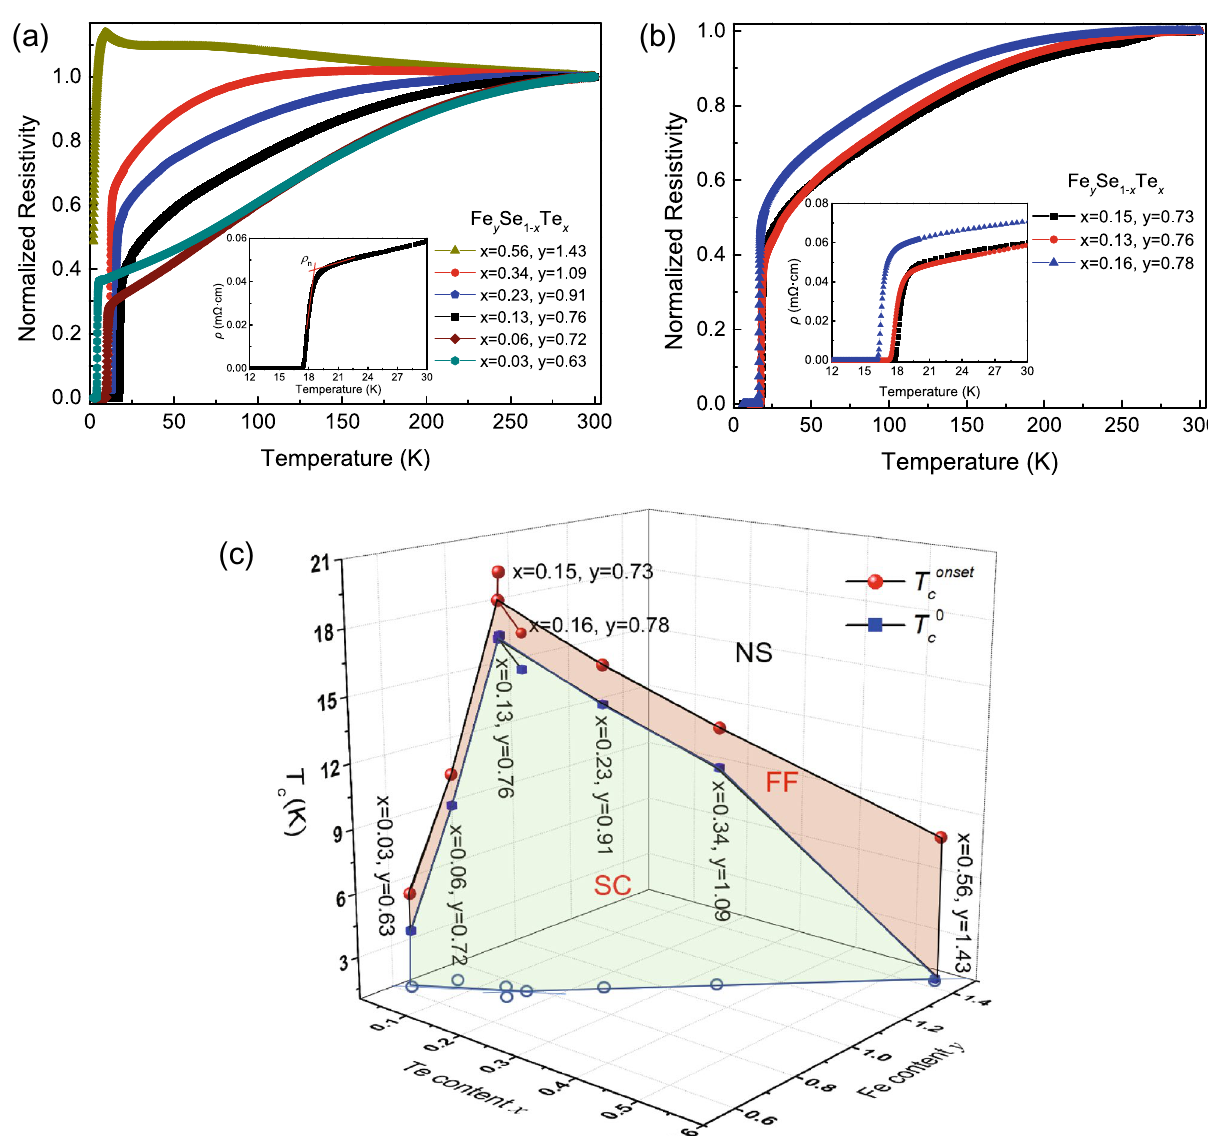
Figure 2. ( a , b ) Temperature dependence of resistivity from 2 to 300 K for Fe y Se 1− x Te x thin films. ( a ) ( x , y ) = (0.03, 0.63), (0.06, 0.72), (0.13, 0.76), (0.23, 0.91), (0.34, 1.09) and (0.56, 1.43). Inset: enlarged plot for the definition of normal-state resistivity ρ n . ( b ) ( x , y ) = (0.15, 0.73), (0.13, 0.76) and (0.16, 0.78). Inset: the enlarged ρ - T curve near T c . ( c ) Sketch of the proposed temperature doping 3D phase diagram for Fe y Se 1− x Te x superconducting system, showing regions of superconductivity (SC), flux flow (FF) and normal state